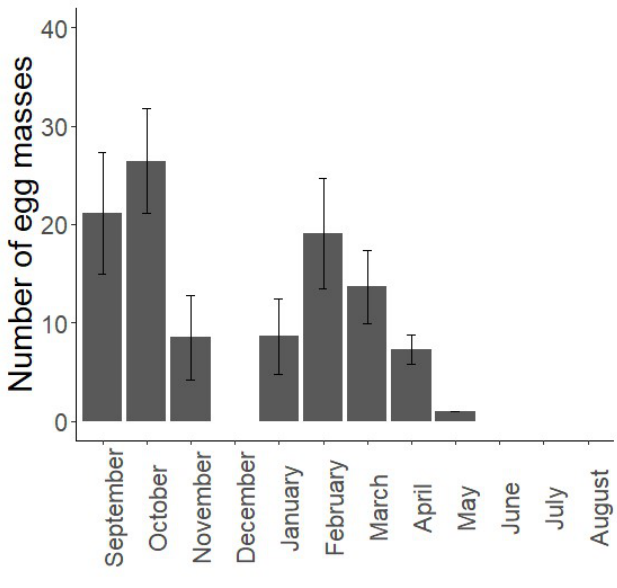
Figure 1: Mean monthly number of egg masses produced by the Parsley Frog for each recorded breeding event. Error bars are standard errors among sites among years. The presence of egg mass es (finding at least one egg mass when visiting a pond) was not significantly different between the two seasons (0.18 ± 0.02, mean ± S.E per visit in autumn and 0.22 ± 0.02 per visit in spring, (over 429 and 470 visits, respectively) χ ² 1 = 2.31, p-value= 0.128, see also Table 2). This variable was not affected by the presence of anurans from other species (larvae), nor by the presence of predators (invertebrates or adult newts). It was positively related to the depth of the pond (χ ² 1 = 20.40, p-value